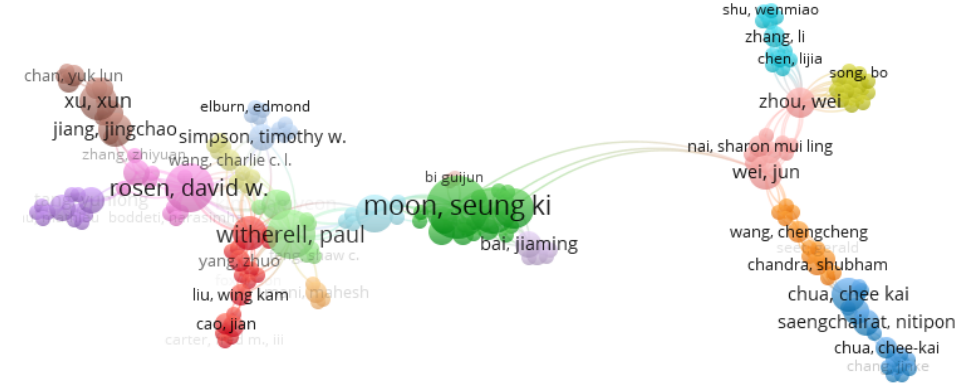
Figure 19. Mapping based on co-authorship showing the network visualization for the first method.